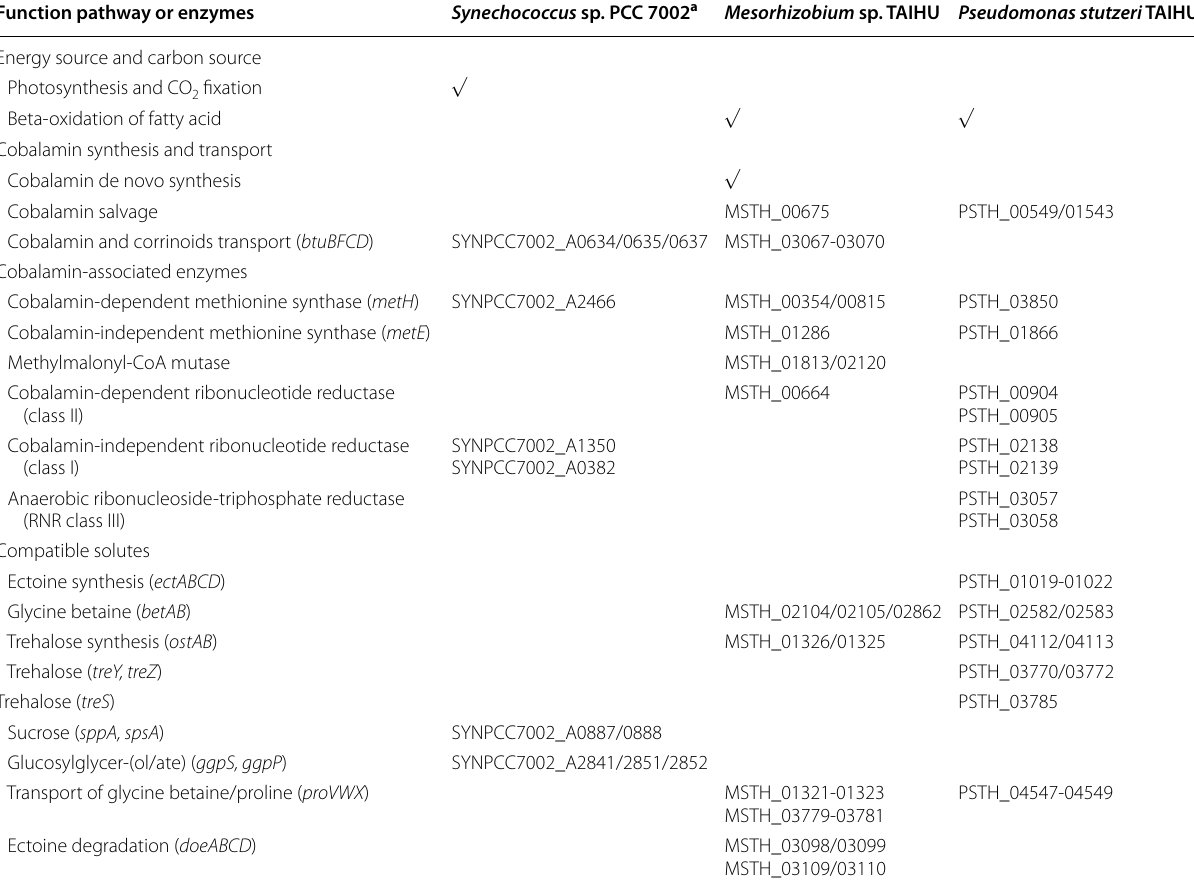
a The check mark indicates that the organism contains the genes responsible for the metabolic ability dictated in the column of the table. Among these, beta- oxidation of fatty acid and biosynthesis of cobalamin are shown in Fig. 4